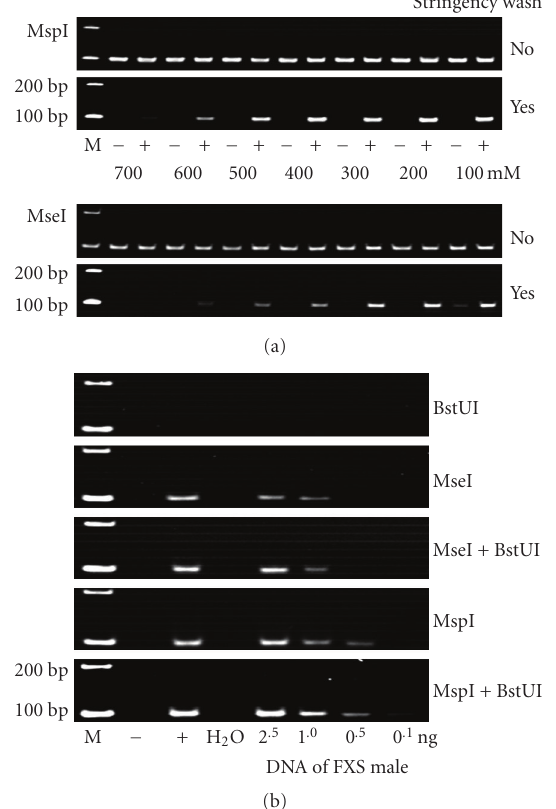
Figure 3: Factors critical for the detection specificity of MB-PCR. (a) NaCl concentration in the stringency wash and enzymatic cleavage of the test DNA are the major factors that can critically determine the capability of MB-PCR in distinguishing between samples with methylated and unmethylated FMR1 alleles. (b) Under the same MB-PCR condition, including a stringency wash with 400mM NaCl and 45 PCR cycles of amplification, the samples cleaved by di ff erent restriction enzyme(s) varied considerably in the detection sensitivity. (–) Control DNA with universally unmethy- lated sequences; (+): control DNA with universally methylated sequences; (M): molecular-size markers